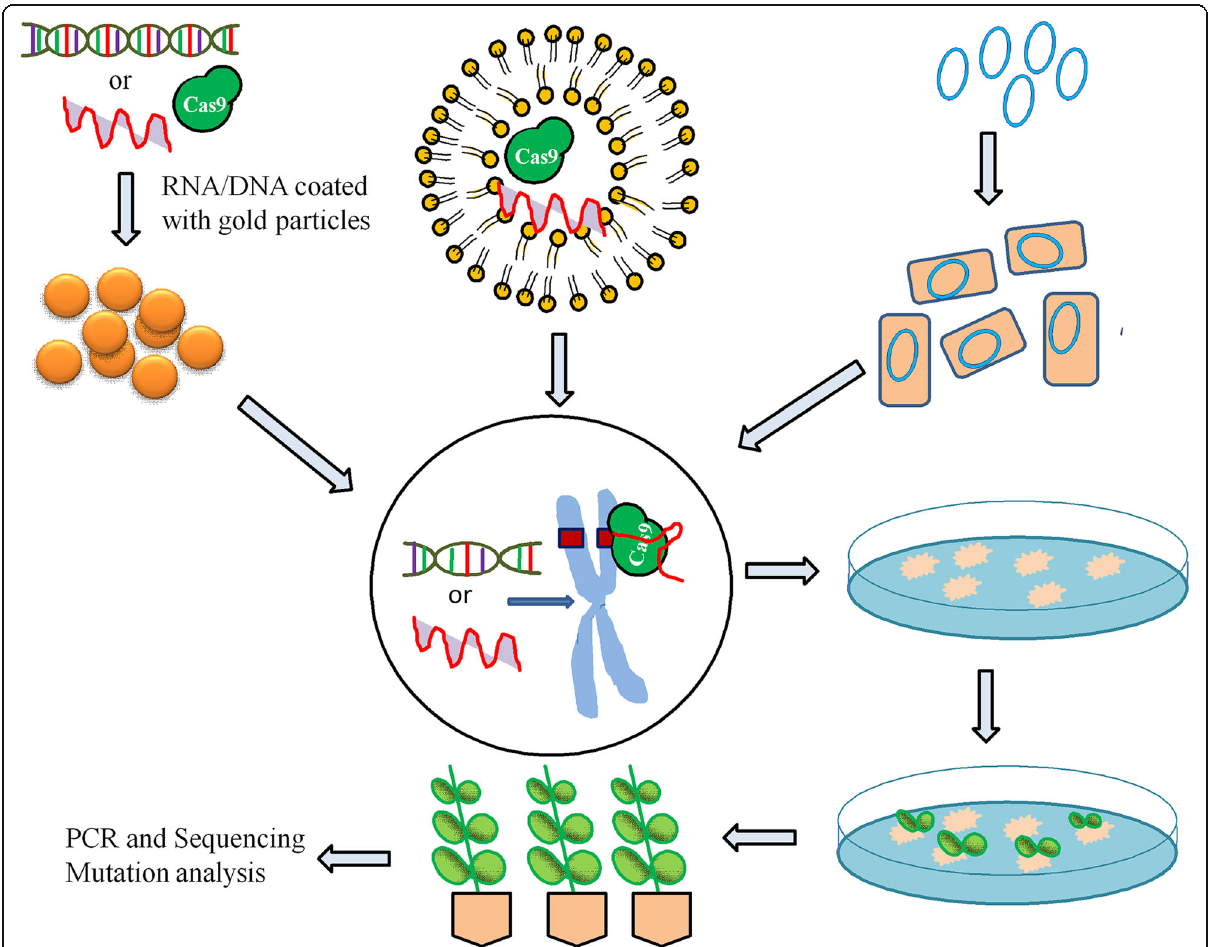
Fig. 2 Schematic representation of CRISPR/Cas9 construct transfer and genome editing processes. CRISPR constructs coated onto gold particles (Gene gun mediated), transferred CRISPR construct into protoplast via PEG, and Agrobacterium strain having CRISPR vector. In the next step, CRISPR constructs are delivered into initial explants. A single plant cells and pictorial representation of gRNA and Cas9 at their target site within the genome. Further, the transformed explants are selected onto appropriate medium in plate. The survived plants were transferred into pots for acclimatization. PCR and Sanger sequencing are generally done for mutation